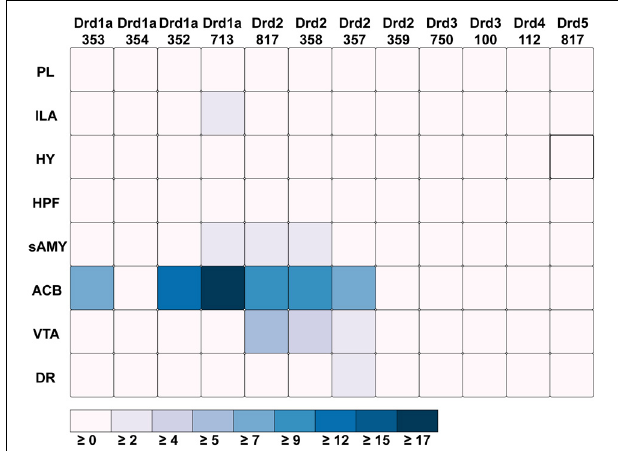
FIGURE 5 | ABADV Heatmap of Dopamine Receptor Genes in Brain Structures Associated with Reward Processing. Each cell in the matrix represents an expression energy value for a particular experiment (column) and brain structure (row). The shade of the color denotes how much expression was found in that cell, where the darker the color, the higher the expression, and the lighter the color, the lower the expression.